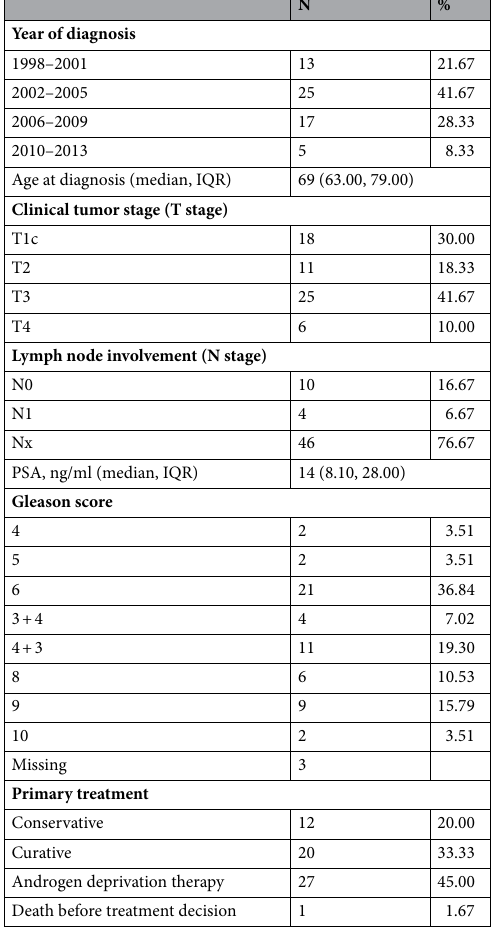
Table 1. Baseline characteristics for the 60 study participants. N sample size; IQR interquartile range; PSA prostate specific